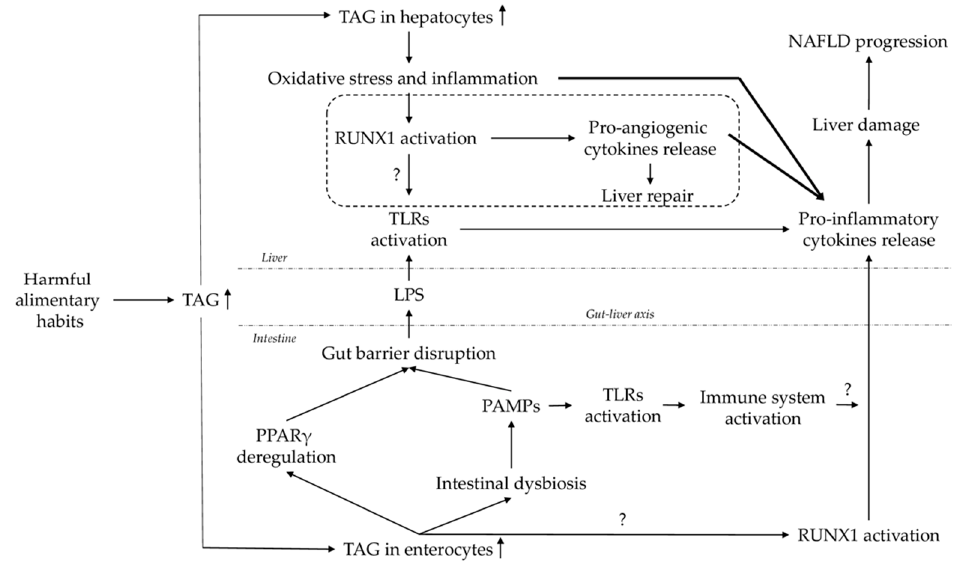
Figure 5. Role of RUNX1 in gut–liver axis implicated in NAFLD pathogenesis. TAG, triglycerides; RUNX1, runt-related transcription factor 1; TLRs, toll-like receptors; NAFLD, nonalcoholic fatty liver disease; LPS, lipopolysaccharides; PPAR γ , peroxisome proliferator-activated receptor gamma; PAMPs, pathogen-associated molecular patterns.